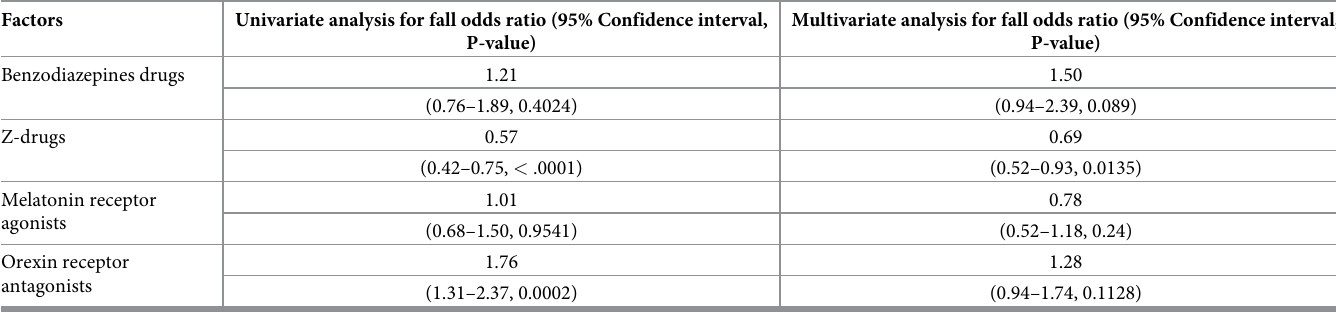
Table 2. Cox regression analysis for fall. Factors Univariate analysis for fall odds ratio (95% Confidence interval,